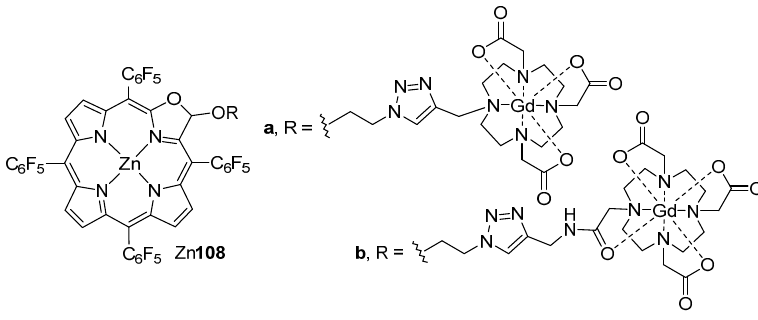
Figure 2. Porpholactol-type compounds studied as multimodal imaging contrast agents [103].